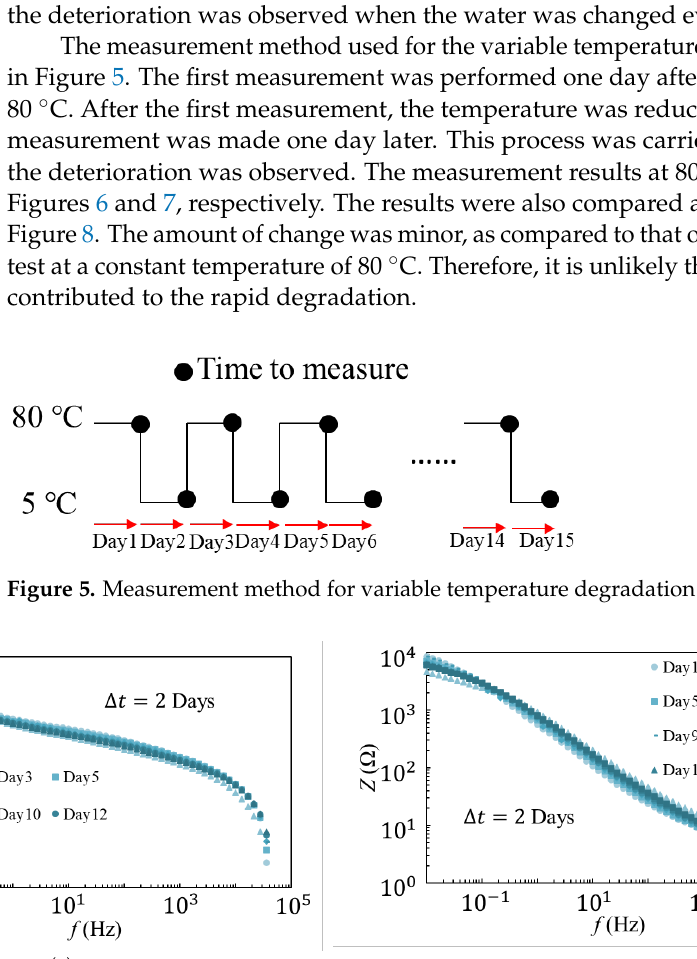
Table 1. Percentage change in C in the 25 °C and 80 °C degradation tests.